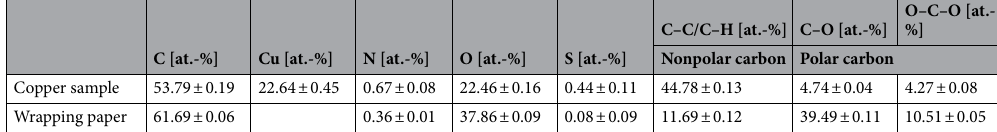
Table 1. Averaged XPS-results of the copper surfaces wrapped in the woodfree tissue and of the wrapping paper itself.